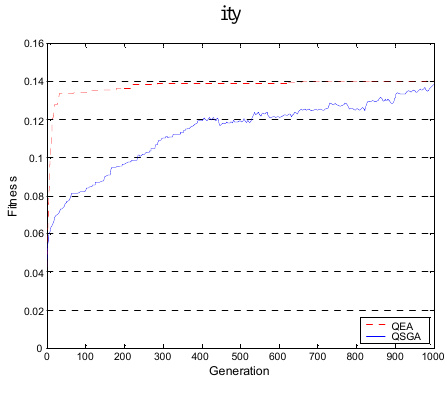
Fig. 8 Comparison of fitness of QEA and QSGA Fig. 8 illustrates the convergence process of QEA